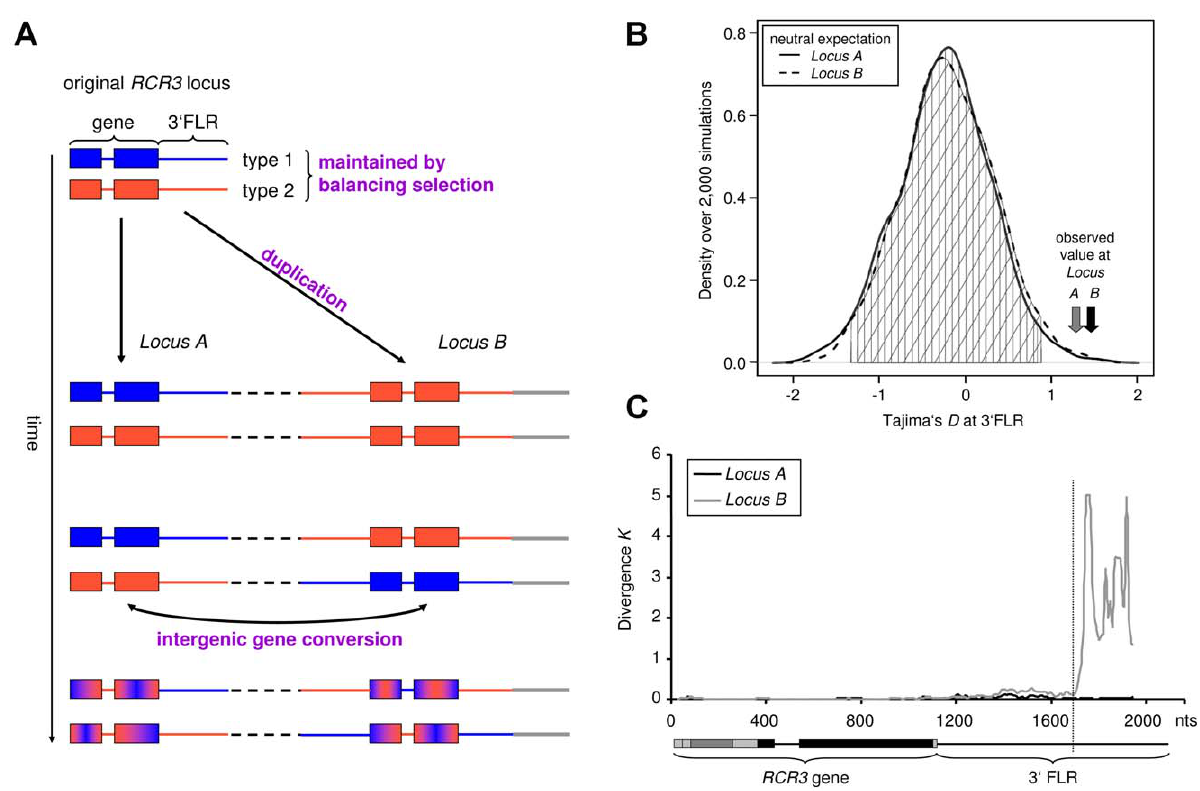
Figure 1. Evolutionary history of the RCR3 gene family ( LocusA and B ). (A) Proposed scenario of RCR3 gene family evolution. The duplication event introduced one of the sequence types (here the red type) into a new genomic location ( Locus B , indicated by grey line). Subsequently, the second sequence type was exported from the original RCR3 locus ( Locus A ) to Locus B . Frequent gene conversion between the two duplicates homogenizes the ORFs, but not the 3 9 FLRs. (B) Distribution of neutral expectation of D T in 3 9 FLRs based on 2,000 coalescent simulations. The grey vertical line indicates the observed average at the reference loci. The observed values at the RCR3 FLRs are outside the 99% confidence intervals (indicated by vertical and diagonal lines). (C) Divergence between Locus A and Locus B to S. lycopersicum RCR3 . The structure underneath the x-axis represents the gene and the 3 9 FLR. The vertical dashed line approximately 580 bp downstream of the stop codon indicates the likely insertion point of the duplicated RCR3 segment into a novel genomic location.